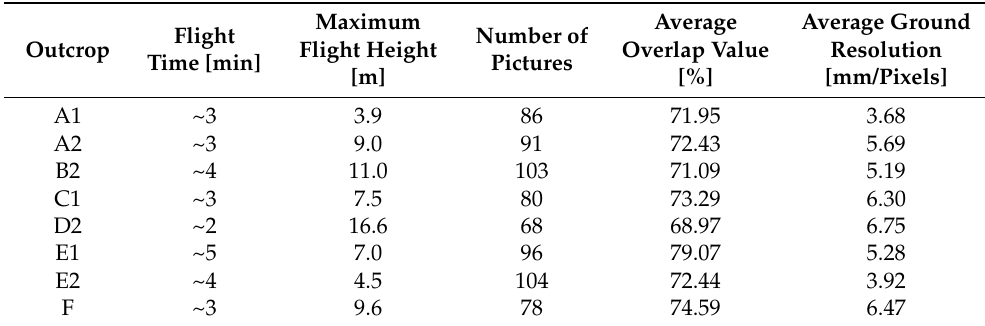
Figure 6. UAV flights showing the positions of the camera (blue framed markers) and the image overlaps of the surveyed outcrops: ( a ) A1, ( b ) A2, ( c ) B2, ( d ) C1, ( e ) D2, ( f ) E1, ( g ) E2, and ( h ) F. Table 2. Main characteristics of the UAV surveys.